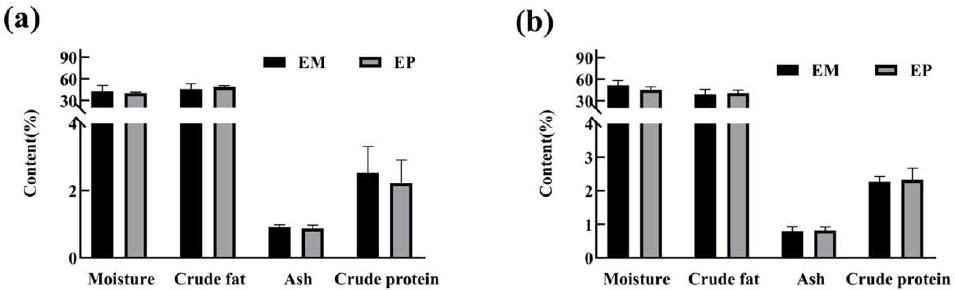
Figure 4. Proximate composition of edible tissues of Chinese mitten crabs in the EM and EP groups: ( a ) female; ( b ) male.